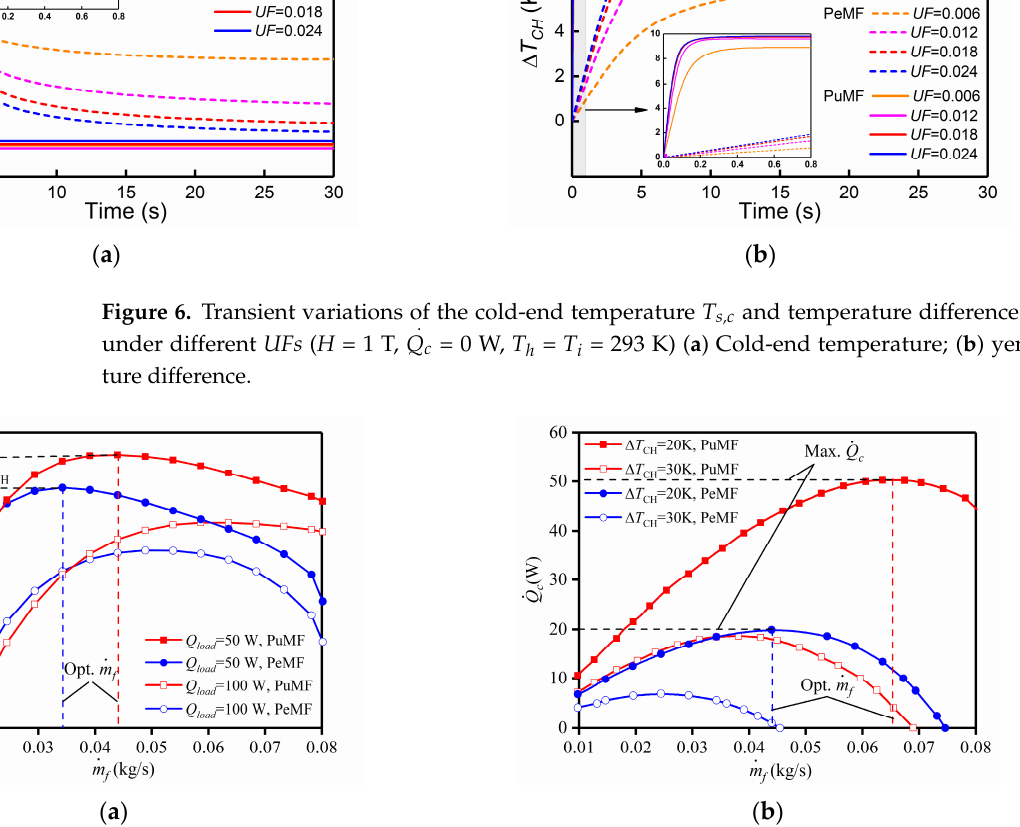
Figure 7. Steady ‐ state temperature difference Δ T CH and cooling capacity 𝑄 (cid:3030) = 1 T, T h = T i = 293 K). ( a ) Temperature difference; ( b ) cooling